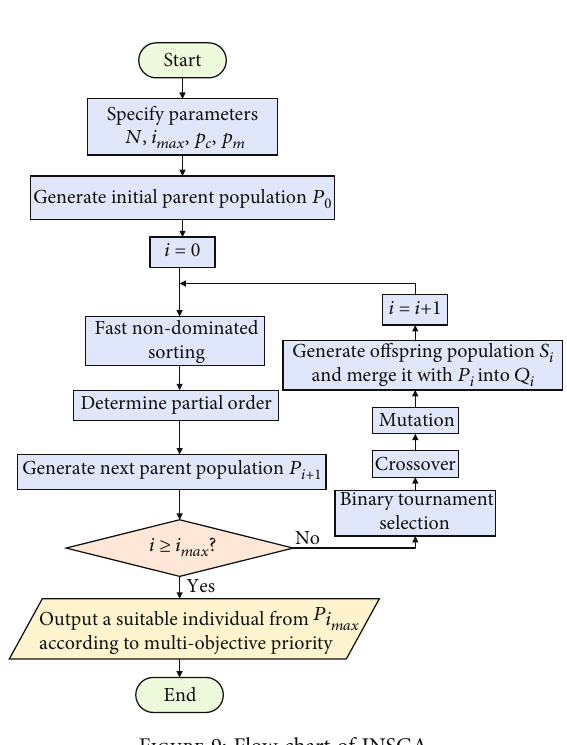
Figure 9: Flow chart of